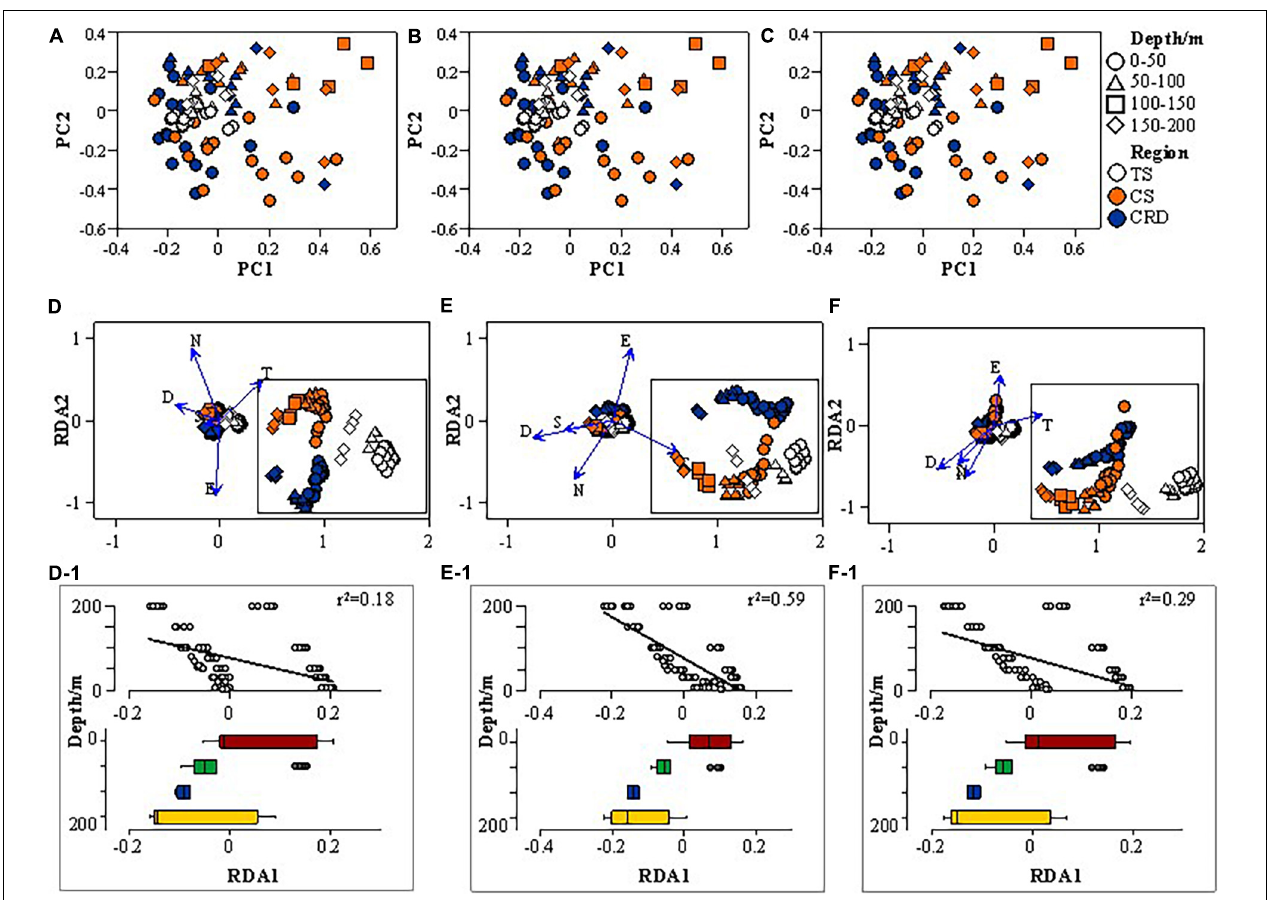
FIGURE 4 | Principal coordinate (PC) analysis performed on community composition dissimilarities (Bray-Curtis) of tintinnid samples in the CRD, CS, and TS in terms of species (A) and LOD size-class (B) , and genera (C) , and RDA analysis performed on the abiotic factors (E, longitude; N, latitudinal; D, Depth; T, Temperature; S, Salinity) in the three investigated regions in terms of species (D) and LOD size-class (E) , and genera (F) , with consideration of depth. Boxplots (D-1–F-1) of the first PC illustrate differences between depth layers. TABLE 4 | Results of the analysis of tintinnid species abundance distribution (SAD) and LOD size-class abundance distribution in the Costa Rica Dome (CRD), Celebes Sea (CS), and Tokara Strait (TS). LOD: lorica oral diameter; AIC: Akaike’s information criterion; mZSM: meta-community zero-sum multinominal. Region No. of stns No. of